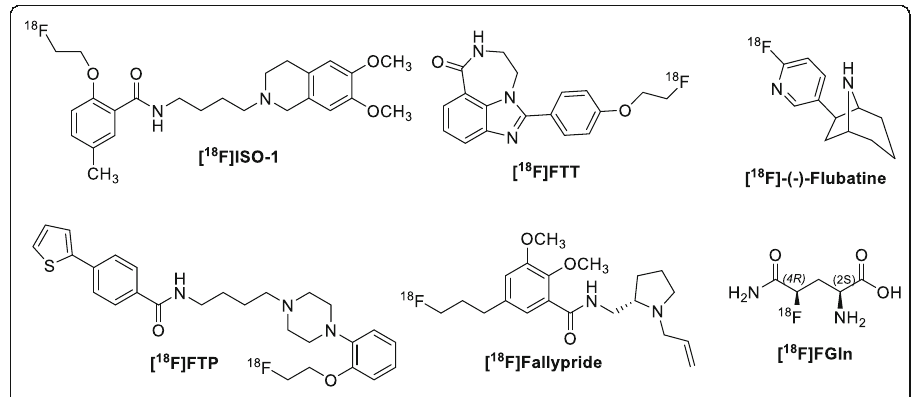
Fig. 1 Structures of six radiotracers synthesized on the AllinOne